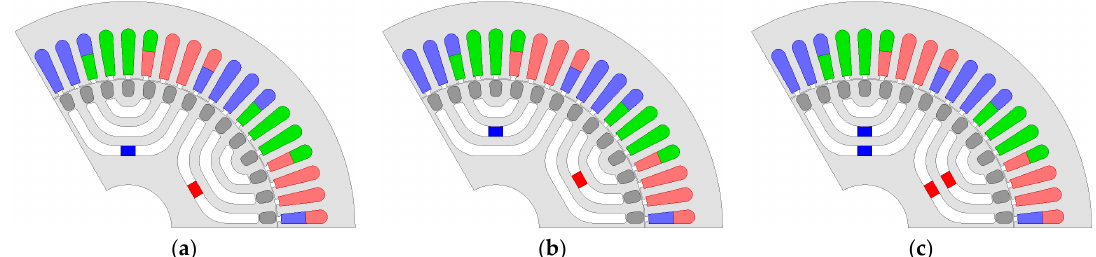
Figure 6. Rotor structure of LS-SynRM with end-ring ( a ) rotor and ( b ) view of A.